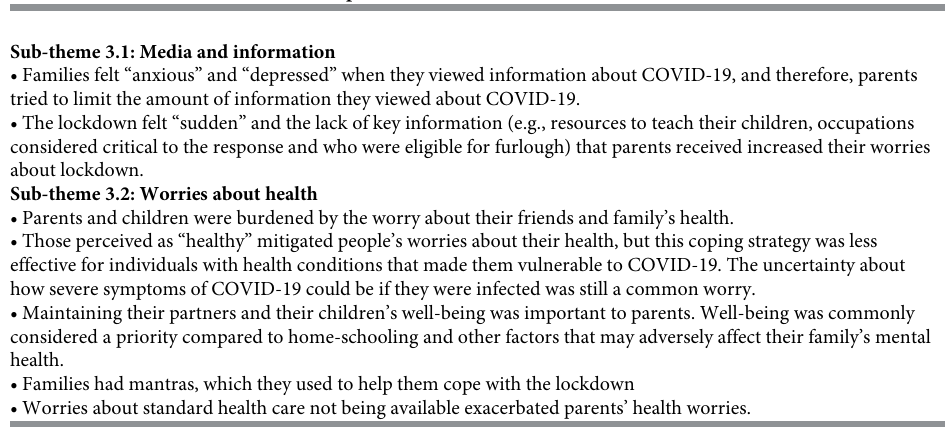
Table 4. The factors that affected how families coped with the COVID-19 school closures and the lockdown guid- ance in relation to Theme 3: Worries about the COVID-19 pandemic. Theme 3: Worries about the COVID-19